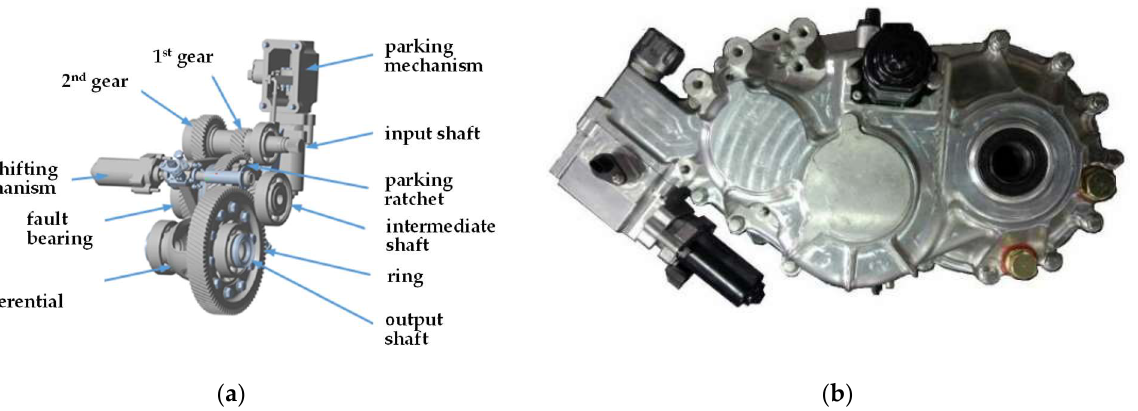
Table 1. Structure parameters of TDCNN.